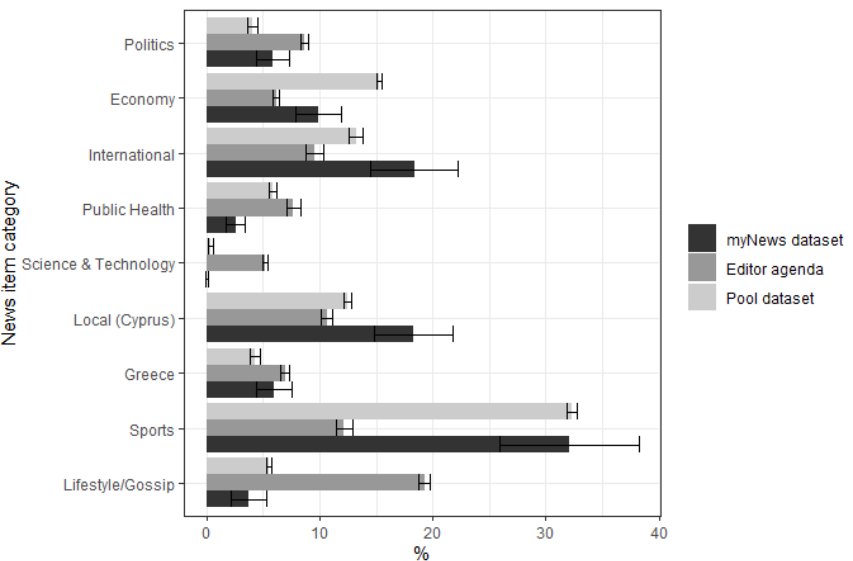
Figure 6. Relative frequencies of news items categories per dataset type.